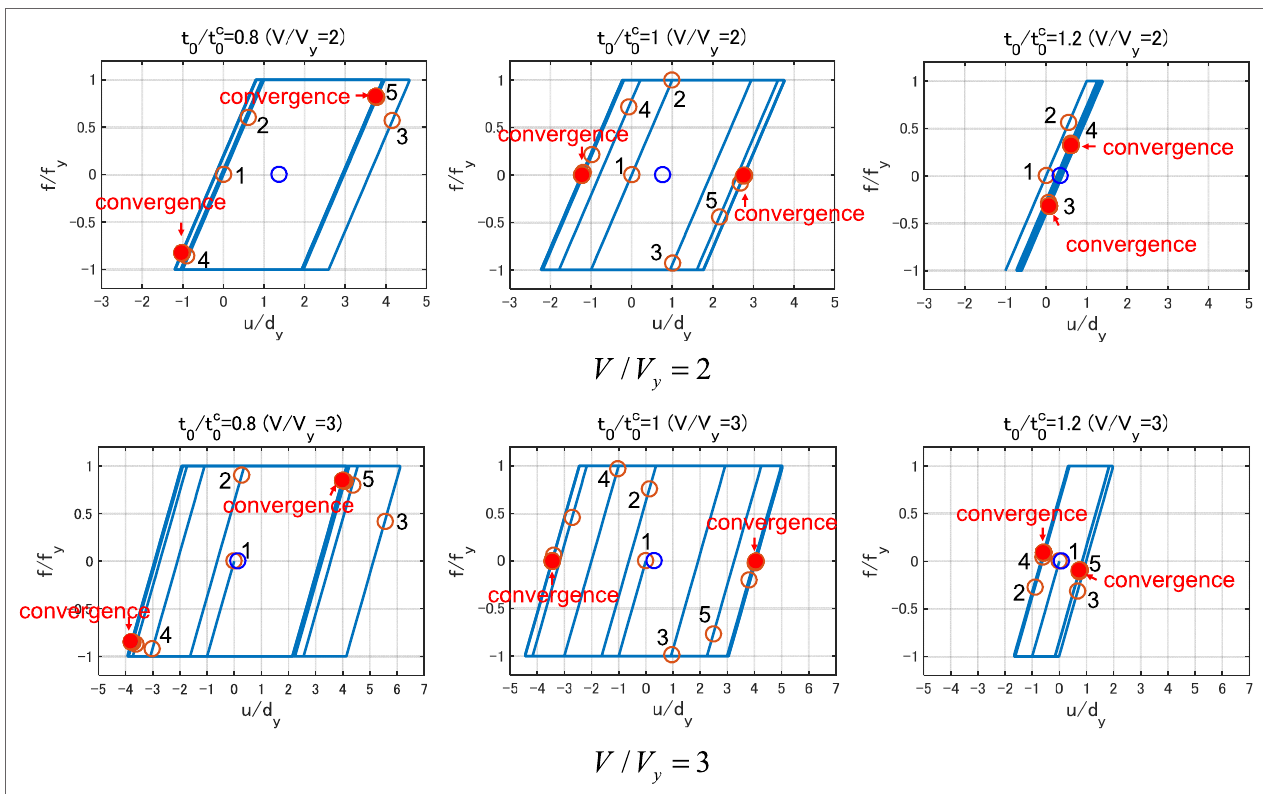
0 0/ . , . , . = ( ) 8 1 12 with two input levels V / V y = 2, 3 (number beside circle: 0 0